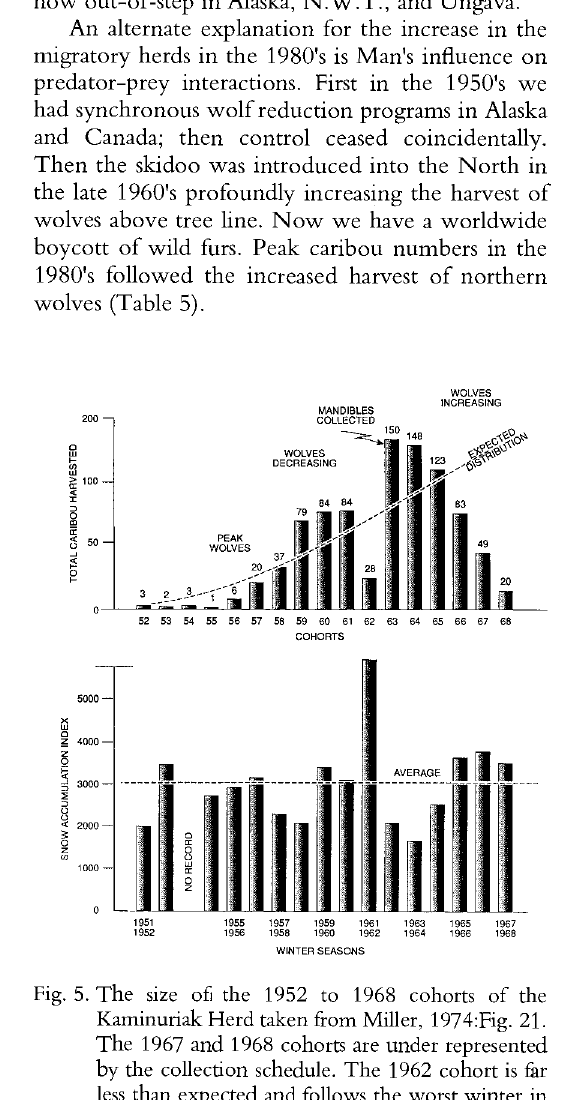
Fig. 5. The size of the 1952 to 1968 cohorts of the Kaminuriak Herd taken from Miller, 1974:Fig. 21. The 1967 and 1968 cohorts are under represented by the collection schedule. The 1962 cohort is far less than expected and follows the worst winter in 16 years (below) when dead animals were obser ved (Kelsall, 1968). Also shown above is the expected age distribution based on animals collec ted by Thomas & Barry (1980) from the adjacent Beverly Herd (age array smoothed by Taylor, 1991). Wolf numbers decreased for the Beverly Herd 1955 to 1961 from control (Kelsall, 1968) and then